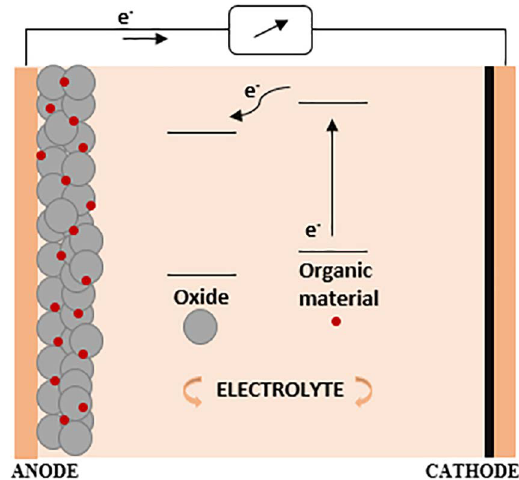
Figure 1. Hybrid solar cell